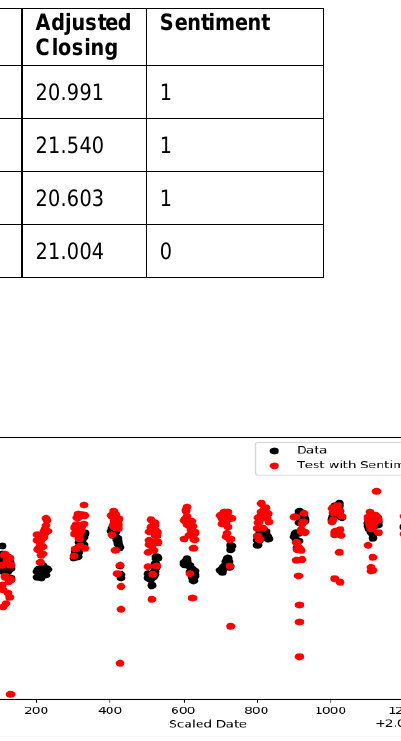
Table 8. Final table to be used as input in prediction algorithm